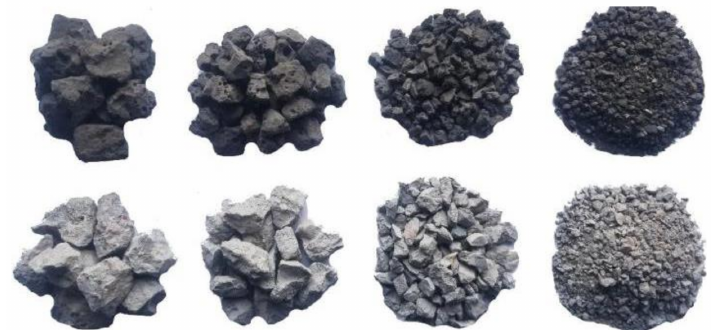
Figure 4. Steel slag and concrete-recycled macadam with different particle